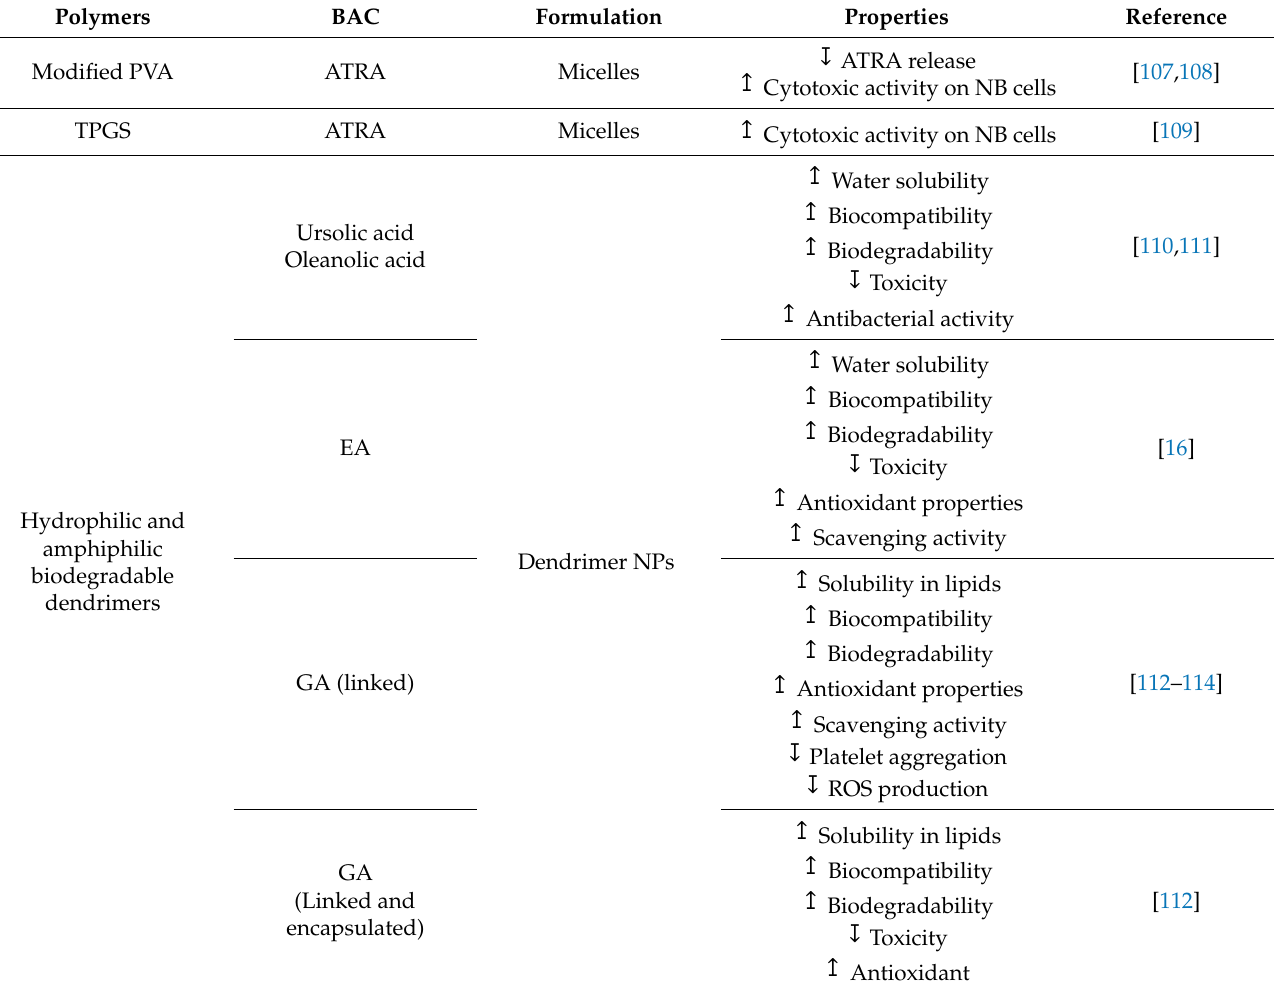
Table 1. The main families of BACs, their sources, nutritional functions and established healthy properties.